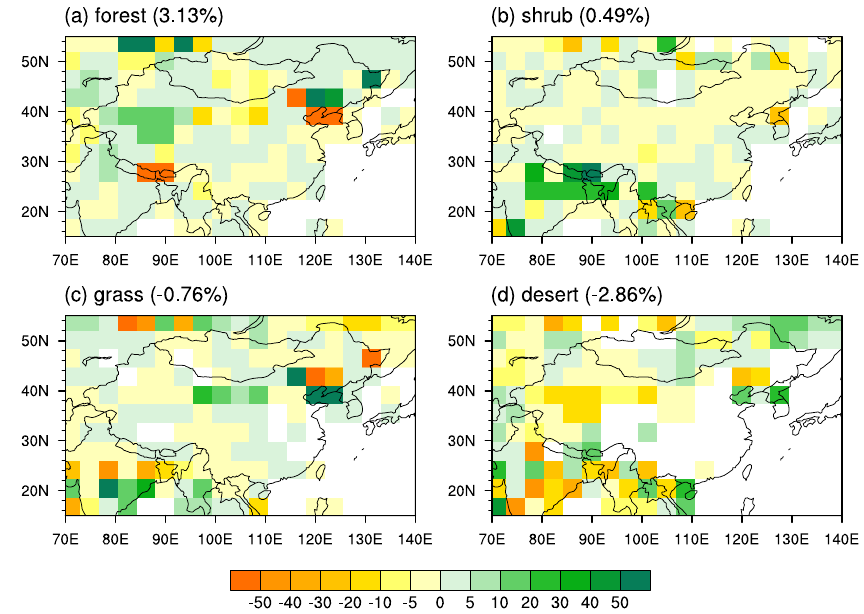
Fig. 8. Simulated vegetation changes, as expressed by the percent of land area within each model grid cell, between AOV(6ka) and AOV(0ka) experiments, with regionally averaged changes over China being given in